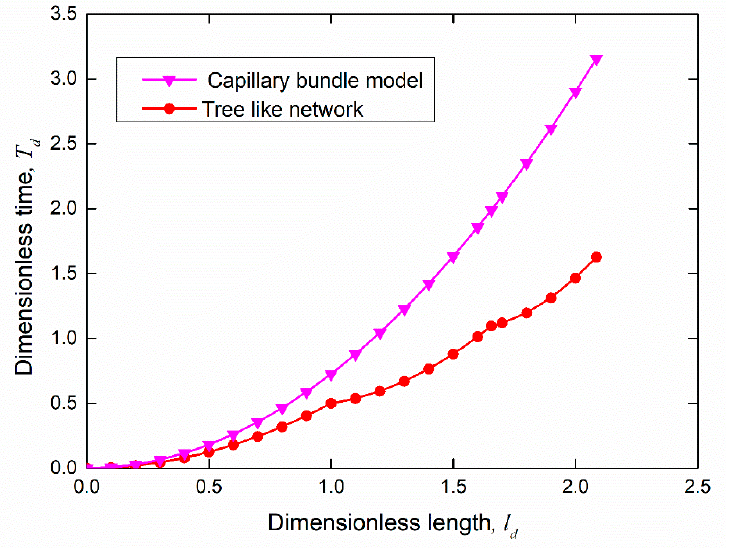
Figure 6. Comparison of T d from capillary bundle model and tree-like network model with changing l d.